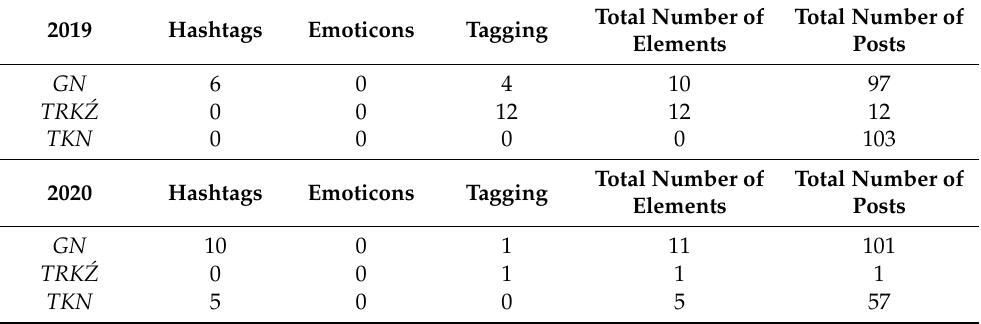
Table 8. Components in the post content on the Instagram profiles of the selected Catholic weeklies